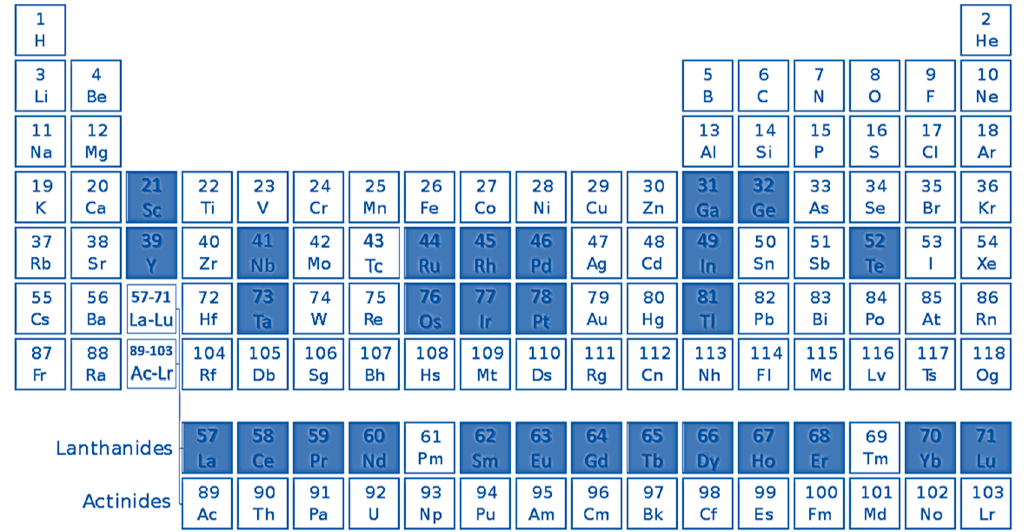
Figure 2. Periodic Table of the Chemical Elements showing in full blue squares the technology-critical elements (TCEs).